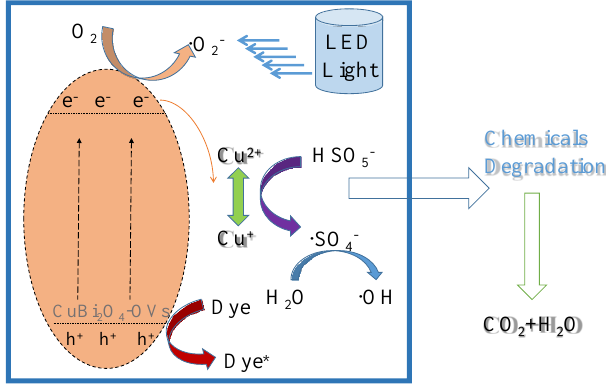
Figure 10. Mechanism of heterogeneous SR-photo-Fenton like degradation of RhB using the CuBi 2 O 4 -OVs catalyst.